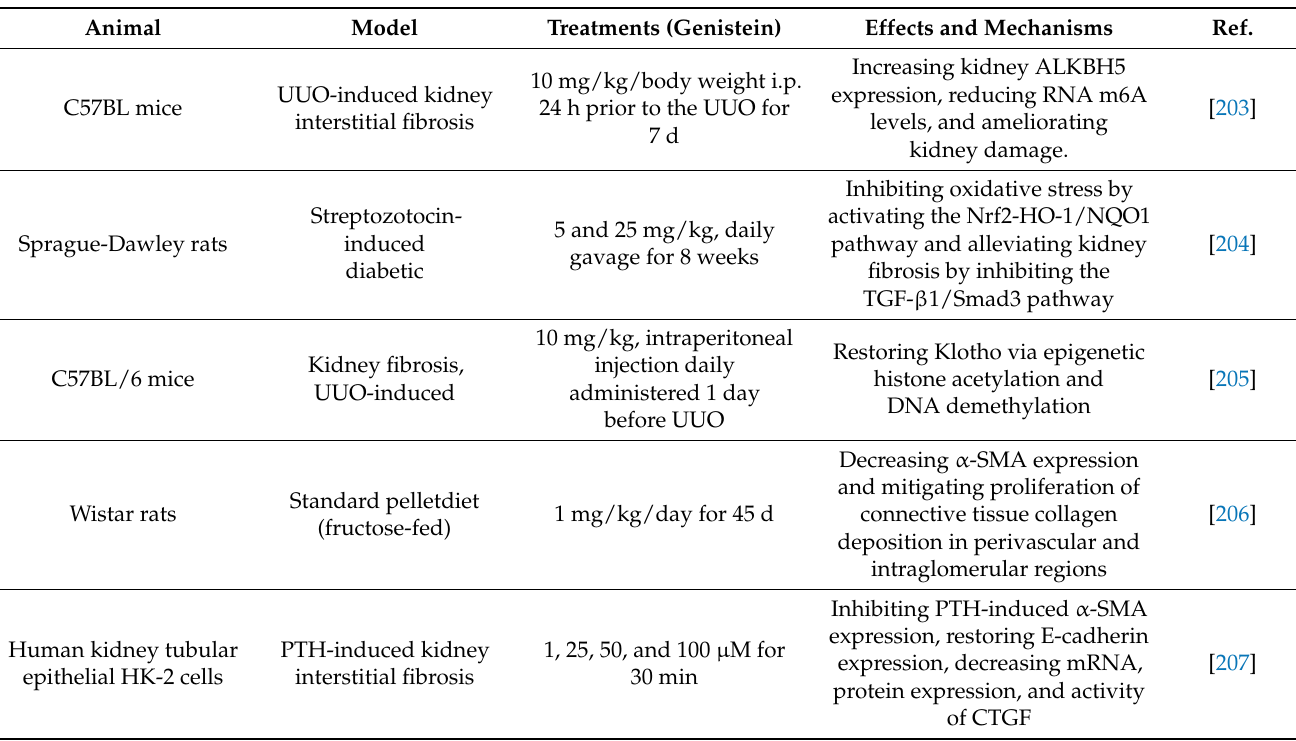
Table 7. The effects of genistein attenuating kidney